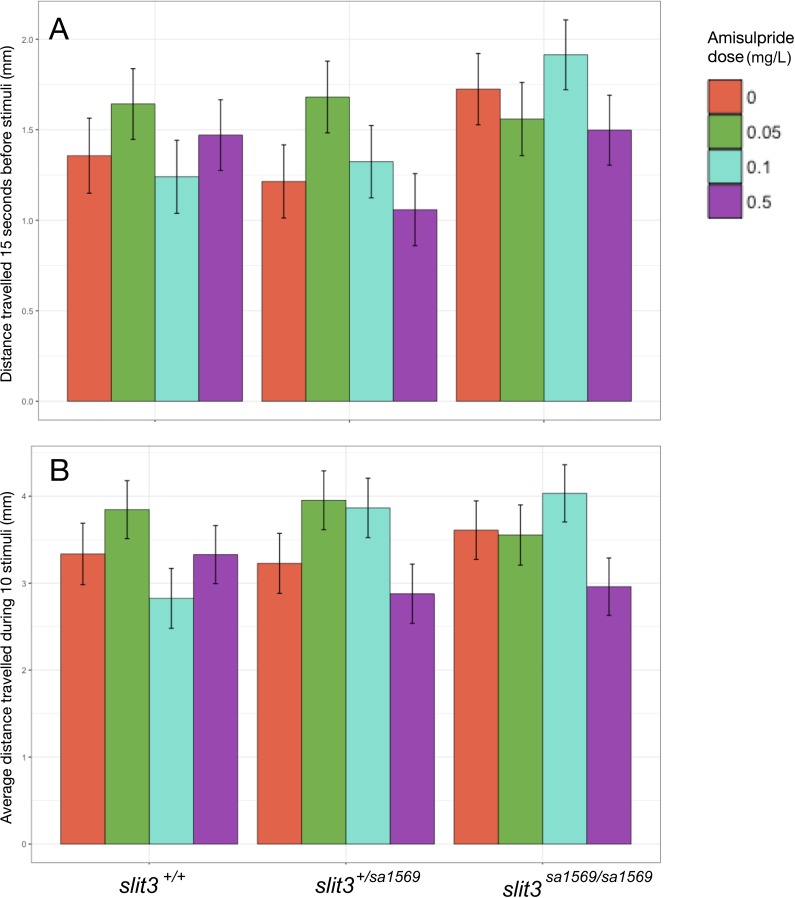
Average distance moved before (Figure 1A) and during startle stimuli (Figure 1B) in wild type and slit3sa1569 mutant five-day-old zebrafish larvae.(A) Basal distance moved as function of amisulpride dose and slit3 genotype. The effect of dose and genotype and their interaction was tested in a linear mixed model. Timepoint, well where the fish were placed and plate were also included as fixed factors and the fish ID as random factor. (B) Distance moved during taps as function of amisulpride dose and slit3 genotype. Dose and genotype and their interaction were examined in a linear mixed model including stimulus number, well, plate used and distance moved before stimuli as fixed factors and Fish ID as random factor. Zebrafish larvae did not differ in the distance travelled before or during startle stimuli as a function of amisulpride dose nor genotype (p>0.05). Bars represent estimated marginal means ± SEM (n = 42–48 fish per group).